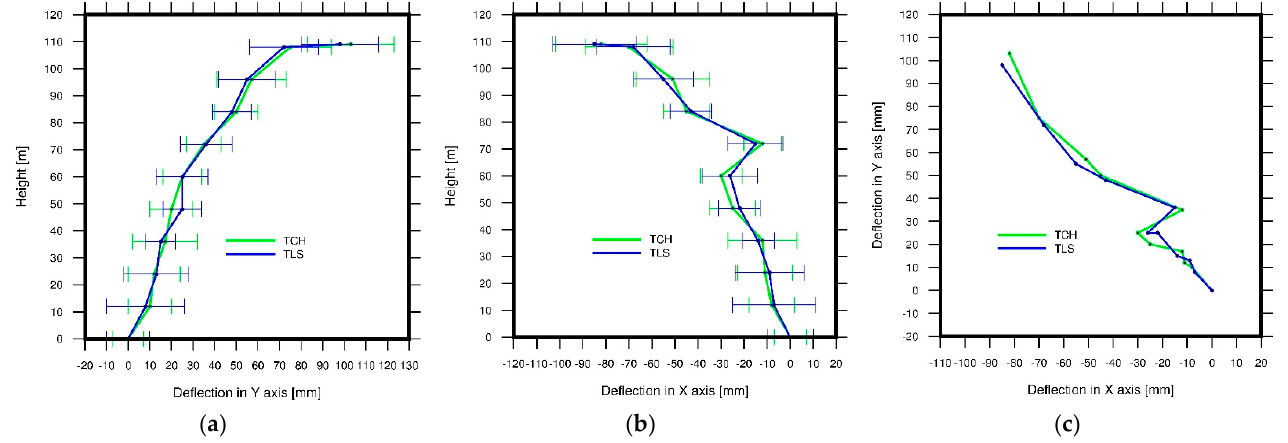
Figure 5. Deflection graphs of the industrial smokestack: ( a ) in the YZ axis, ( b ) in the XZ axis, and ( c ) in the XY axis. In XZ and YZ, axis vectors are depicted with an error bar in millimeters. The deflection of the smokestack axis, as measured with the two methods, are in the same directions. The axis visibly deflects in the direction consistent with the prevailing wind direction, i.e., in the south-east direction. On the measurement day the wind was in the west direction. It might have contributed to the deflection of the axis by several hundredths of a millimeter. The smokestack axis deflects evenly up to the height of 70–80 m, and an increase in deflection value is observed in its upper part. This fact may be due to sudden gusts of wind, which cause the uppermost part of the smokestack to deflect more in consistence with the prevailing wind direction. The deflection of the highest measured point on the smokestack, close to its top, is 132 mm. The safety limit is not exceeded. The smokestack is non-operational and used as a tower for telecommunication antennas. ( c ) Figure 6. Deflection graphs of the cooling tower: ( a ) in the YZ axis, ( b ) in the XZ axis, ( c ) in the XY axis. In XZ and YZ, axis vectors are depicted with an error bar in millimeters. The cooling tower-axis shows a minor deflection, which is natural, as the object is not tall and rather wide. Although the envelope of the cooling tower is very thin relative